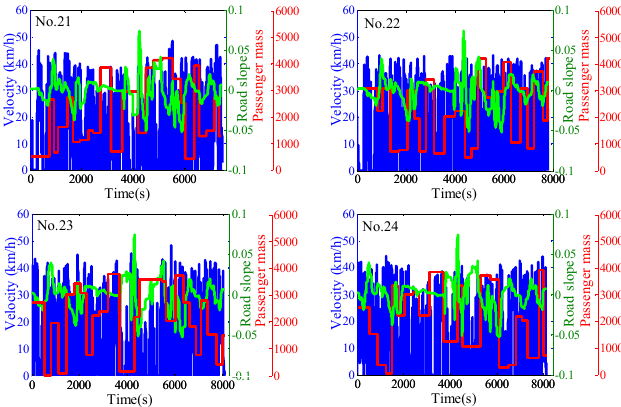
Figure 20. The combined driving cycles from No.21 to No.24.